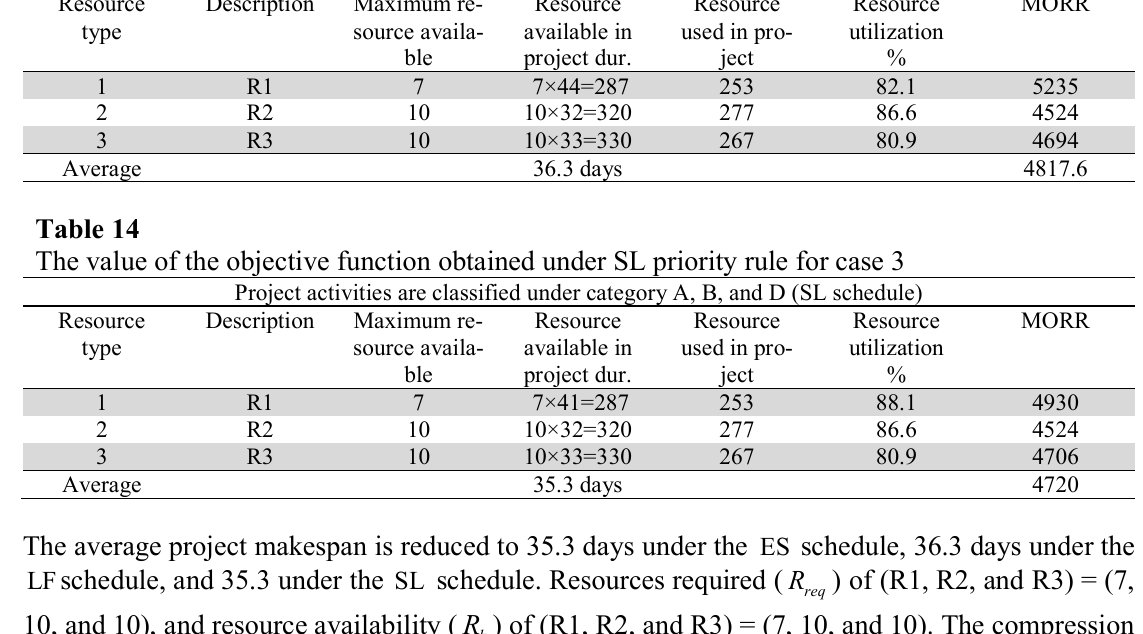
The value of the objective function obtained under LF priority rule for case 3 Project activities under are classified under category A, B, and D (LF schedule) Resource